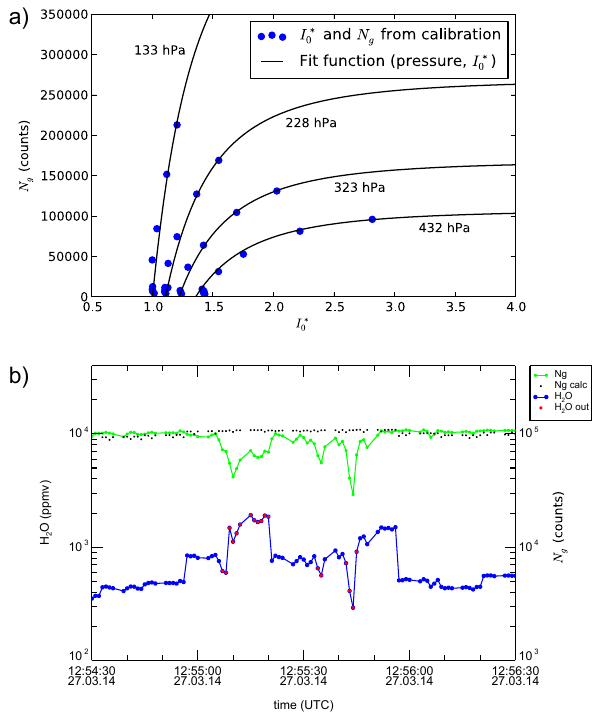
Figure 8. Quality check procedure for high WVMRs: (a) correla- tion between I ∗ and N g (calibration data, blue dots) with pressure- 0 dependent fit function (black lines); (b) time series of calculated count rate ( N g , calc , black dots), measured count rate ( N g , green dots), water vapor (blue dots), and rejected water vapor (H 2 O out, red dots) during one flight of